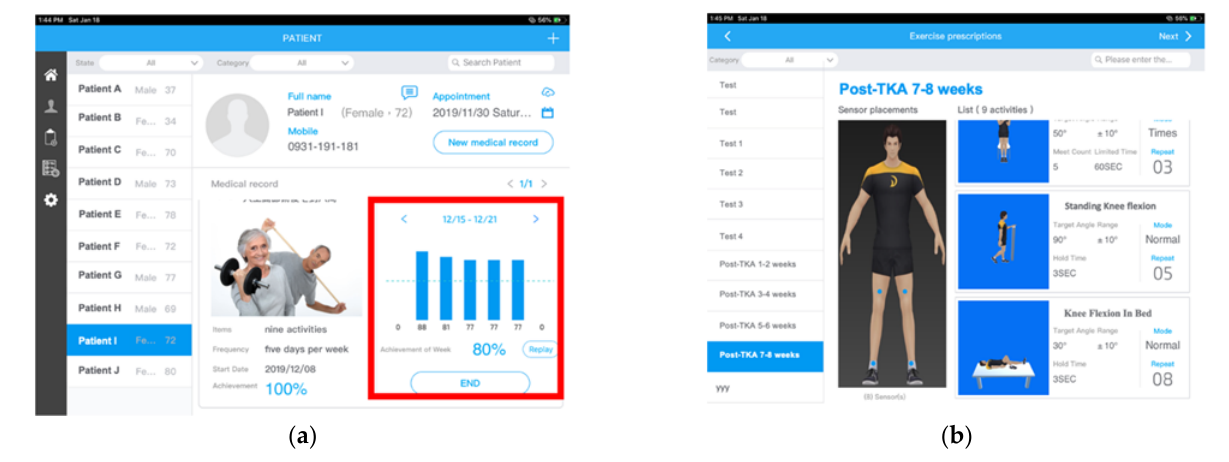
Figure 4. Mobile app for physiotherapists and physicians: ( a ) the daily and weekly ECR of each patient is displayed with patient information; ( b ) doctors assign daily exercises with specified targeted angles, holding times, and numbers of repetitions.